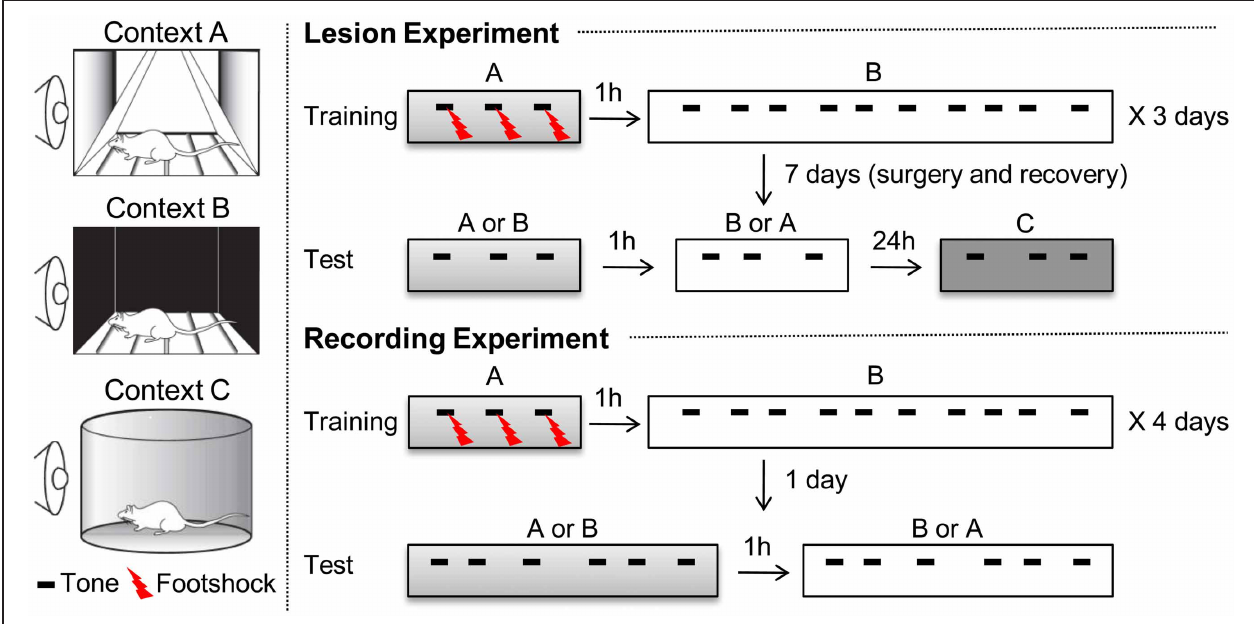
FIGURE 1 | Experimental procedure for context-dependent fear discrimination (CDFD). Two different contexts, denoted as A and B, were used for training. During training, rats were given two alternating sessions on the same day, separated by 1h: one in Context A and the other in Context B. Training lasted for 3 days. In Context A, three parings of the CS and US were presented. In Context B, they were given ten CS-only trials. Training lasted for 3 days. Twenty-four hours after the final training session, the PL lesion and